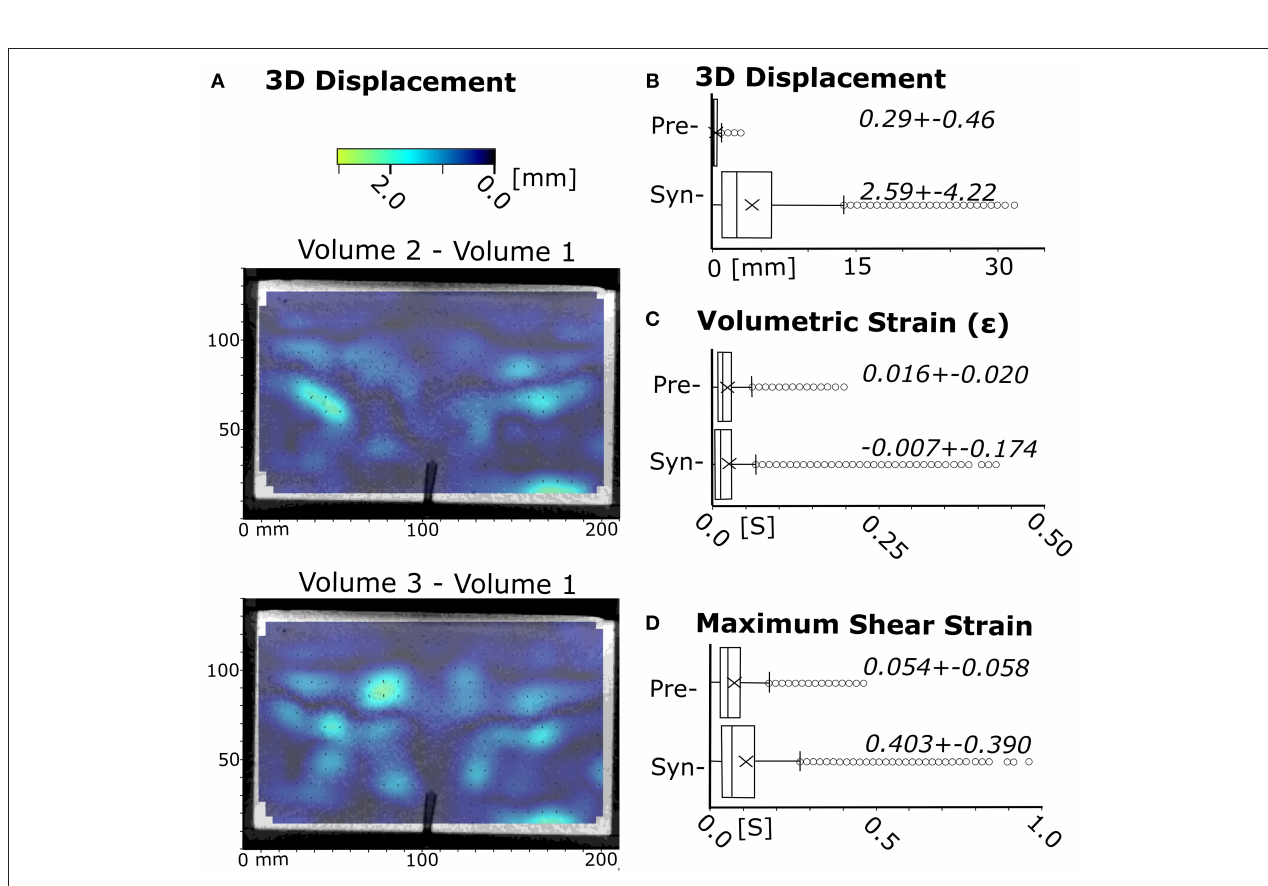
FIGURE 4 | Assessment of Digital Volume Correlation precision in experiment SPCTIN02. (A) x-z vertical cross-sections through 3D displacement fields calculated between, respectively the second and third CT image and the first one acquired prior to golden syrup injection, i.e., a pre-experimental state; (B–D) Median and standard deviations of 3D displacement vector lengths, volumetric strain and maximum shear strain in pre-experiment CT images and the last differential syn-experiment timestep, n = 47,400 voxels.